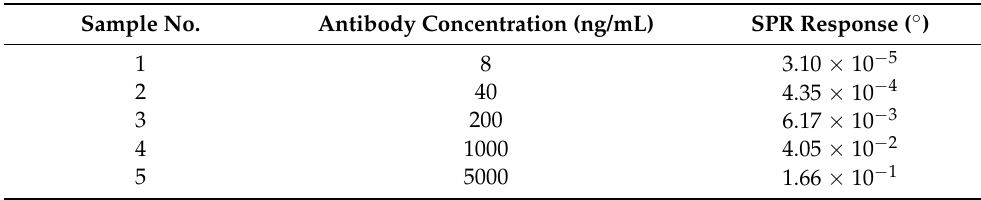
Table 1. Results of initial anti-RBD antibody detection test. Sample No.